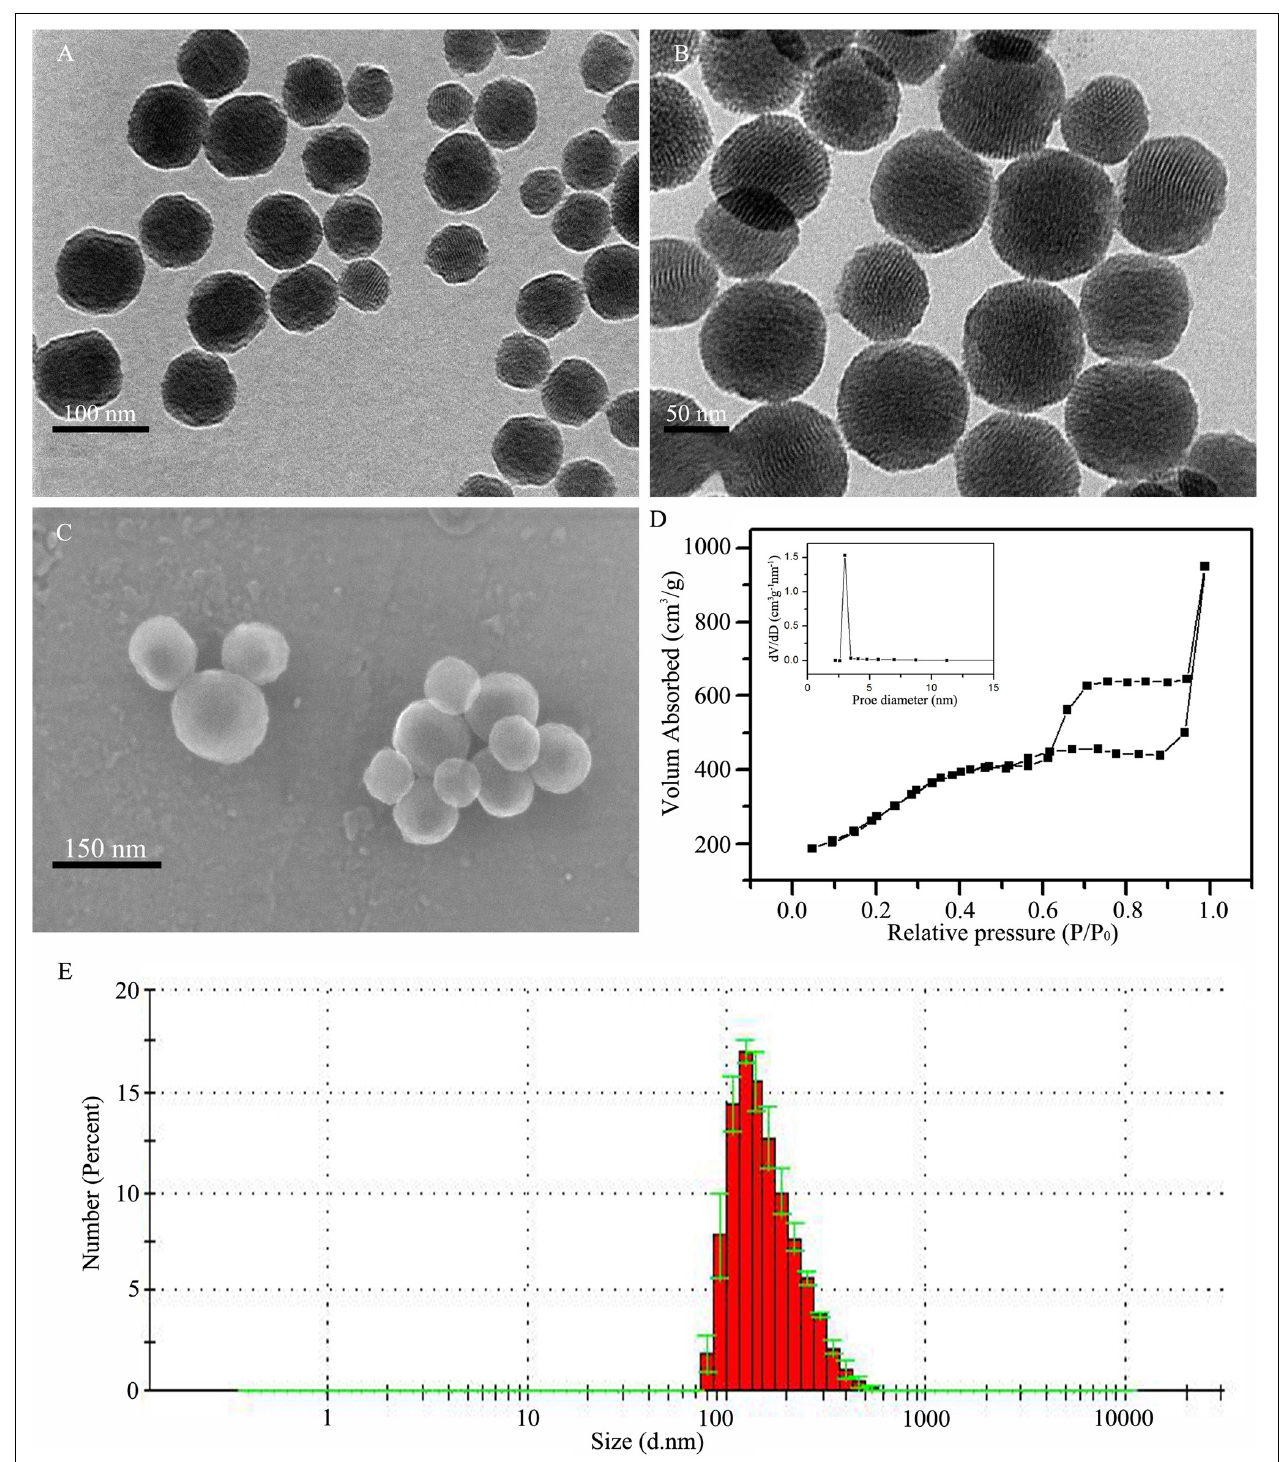
FIGURE 2 | Synthesis and characterization of MSNs. (A,B) TEM image of MSNs at different magnifications. (C) SEM image of MSNs. (D) The mesoporous morphology and mesoporous distribution (inset) of MSNs were determined by the N 2 adsorption-desorption isotherms. (E) Dynamic light scattering (DLS) determination of the particle diameter of